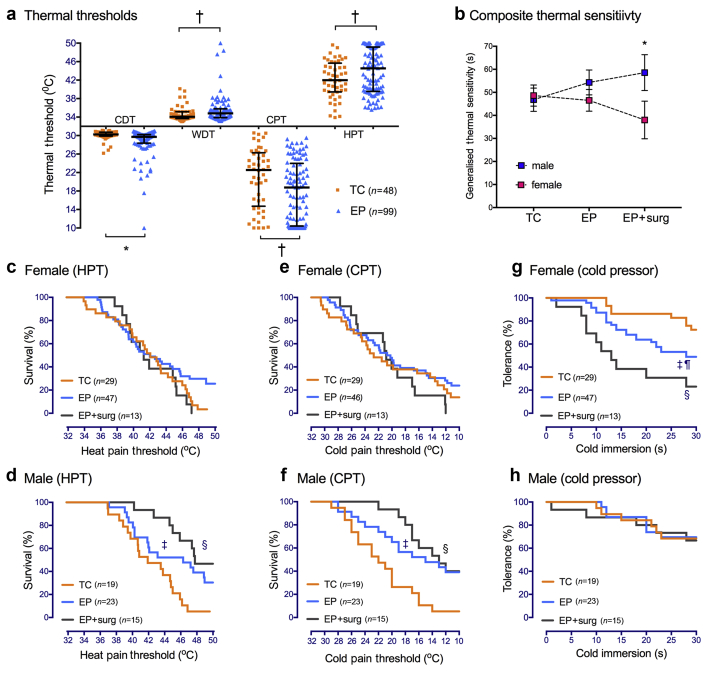
Thermal sensitivity is influenced by EP status, sex, and stimulus intensity. (a) Raw thermal threshold data in extreme preterm (EP) and term control (TC) participants show group differences in cold detection threshold (CDT), warm detection threshold (WDT), cold pain threshold (CPT), and heat pain threshold (HPT). Scatter plot and median (inter-quartile range); *P<0.01, †P<0.05. (b) Generalised thermal sensitivity (composite of time to HPT, time to CPT, and duration of cold pressor immersion; maximum score 70) demonstrates increased tolerance of thermal stimuli (decreased sensitivity) in EP males with prior neonatal surgery (EP+surg) but increased sensitivity in females. Data points=mean [95%CI] two-way ANOVA *P<0.01 male vs female EP+surgery. (c–h) Thermal survival curves for HPT in females (c) and males (d) and CPT in females (e) and males (f) demonstrate decreased sensitivity in males, particularly after neonatal surgery (EP+surg). Cold pressor tolerance was significantly reduced in EP females (g), particularly after neonatal surgery, but did not differ in males (h). Log rank Mantel–Cox comparison: ‡P<0.05, TC vs EP; ¶P<0.05, TC vs EP; §P<0.01 TC vs EP + surg.